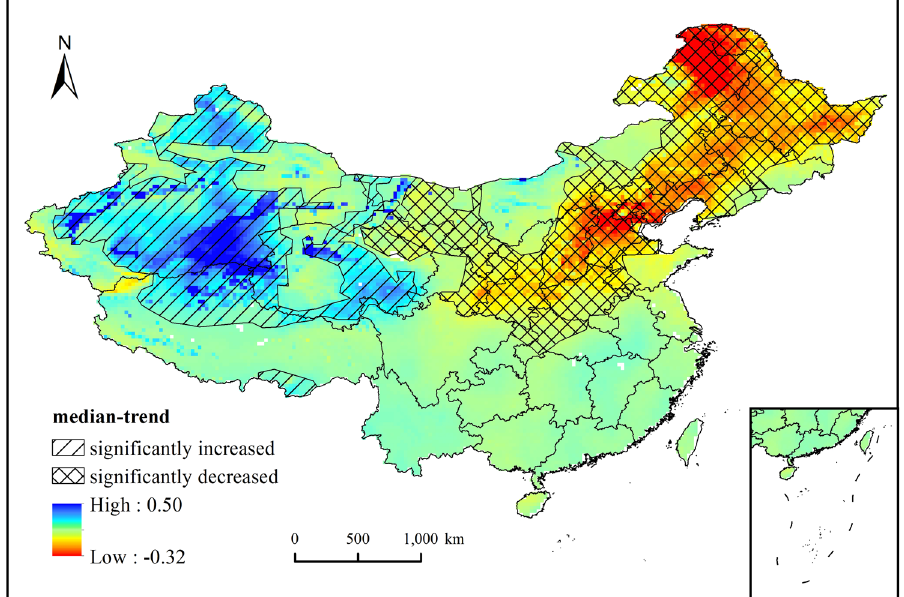
Figure 2. The spatial distribution of TWSA variation trends ( p < 0.05). This map was created using ArcGIS 10.1 software, visit http://desktop.arcgis.com/en/ for more